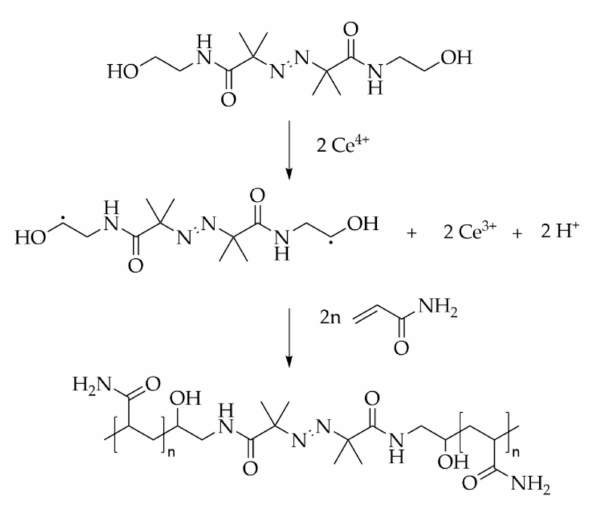
Figure 7. Mechanism of polymerization of acrylamide using Ce 4+ /VA-086 redox